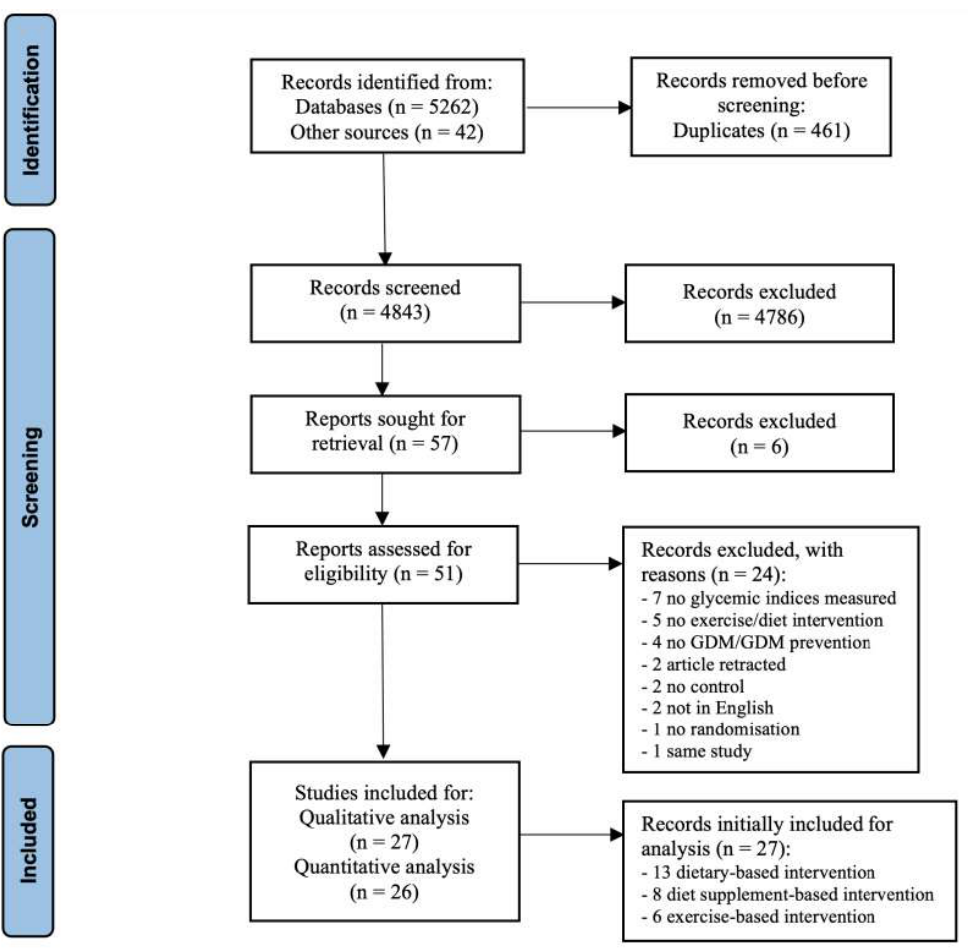
Figure 1. PRISMA flow diagram of study selection adapted from Page MJ, et al. (2020) [22].